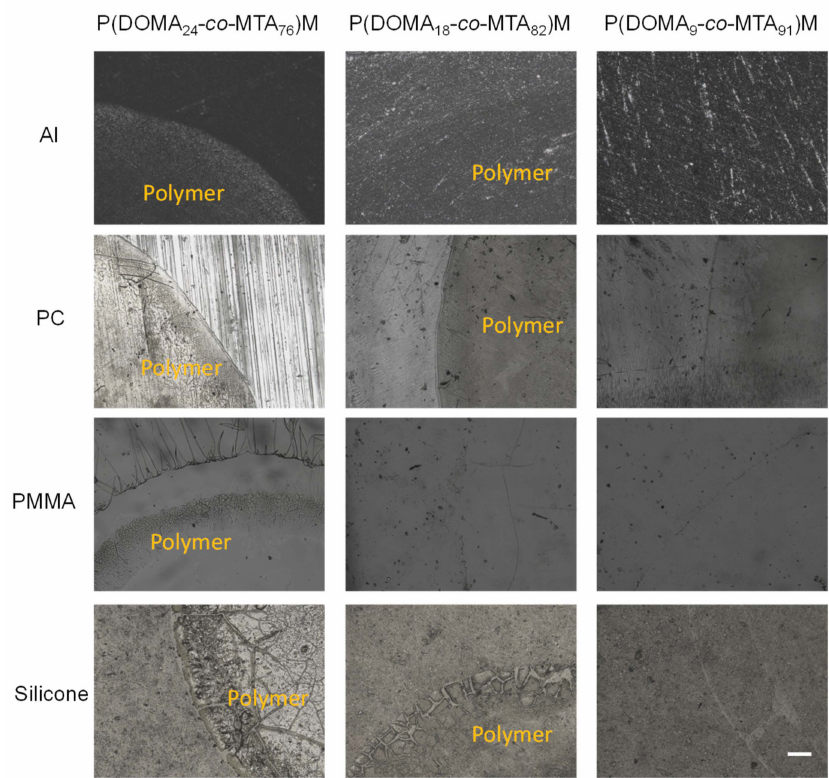
Figure 4. Optical images of coatings made from P(DOMA x - co -MTA y )M copolymers onto di ff erent substrates. Scale bar = 250 µ